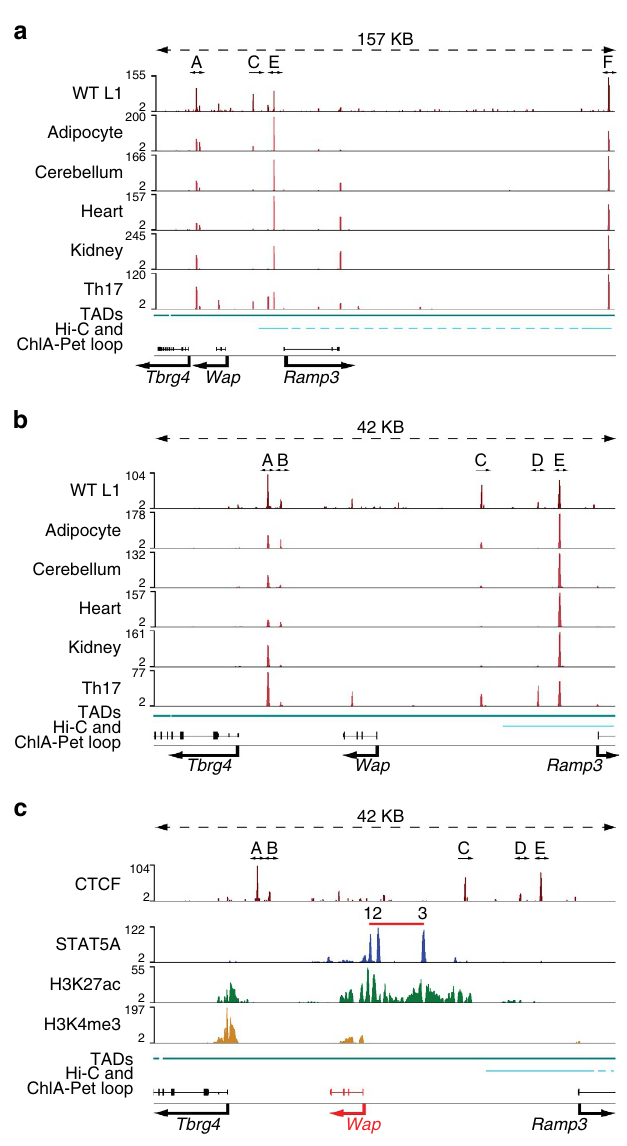
Figure 2 | CTCF-binding sites and enhancers in the extended Wap locus. ( a ) CTCF ChIP-seq data from mammary tissue at day 1 of lactation and from several non-mammary cells (GSE29218, GSE40918, GSE74189, GSE74826). The lower part shows the topological associated domain 9 (TAD) (bin size 40KB) in cyan and a ChIA-PET and Hi-C loop 7 with site E and F as anchor in light blue. ( b ) CTCF binding to sites A and F was conserved across cell types. CTCF binding to sites B, C and D was cell- preferential. ( c ) The Wap locus is characterized by its tripartite mammary- specific super-enhancer (shown as red bar) and five flanking CTCF sites (GSE74826), which separate it from the two neighbouring genes, Tbrg4 and Ramp3 . Both are expressed at low levels (FPKM o 13) in mammary tissue. Ramp3 is preferentially expressed in the cerebellum, whereas Tbrg4 is widely expressed. Two CTCF-binding sites are 3 0 of the Wap gene body and three 5 0 sites are located between the super-enhancer and Ramp3 . The Wap locus is located within a topological-associated domain 9 (TAD) (bin size 40KB). CTCF site E anchors a ChIA-PET and Hi-C loop 7